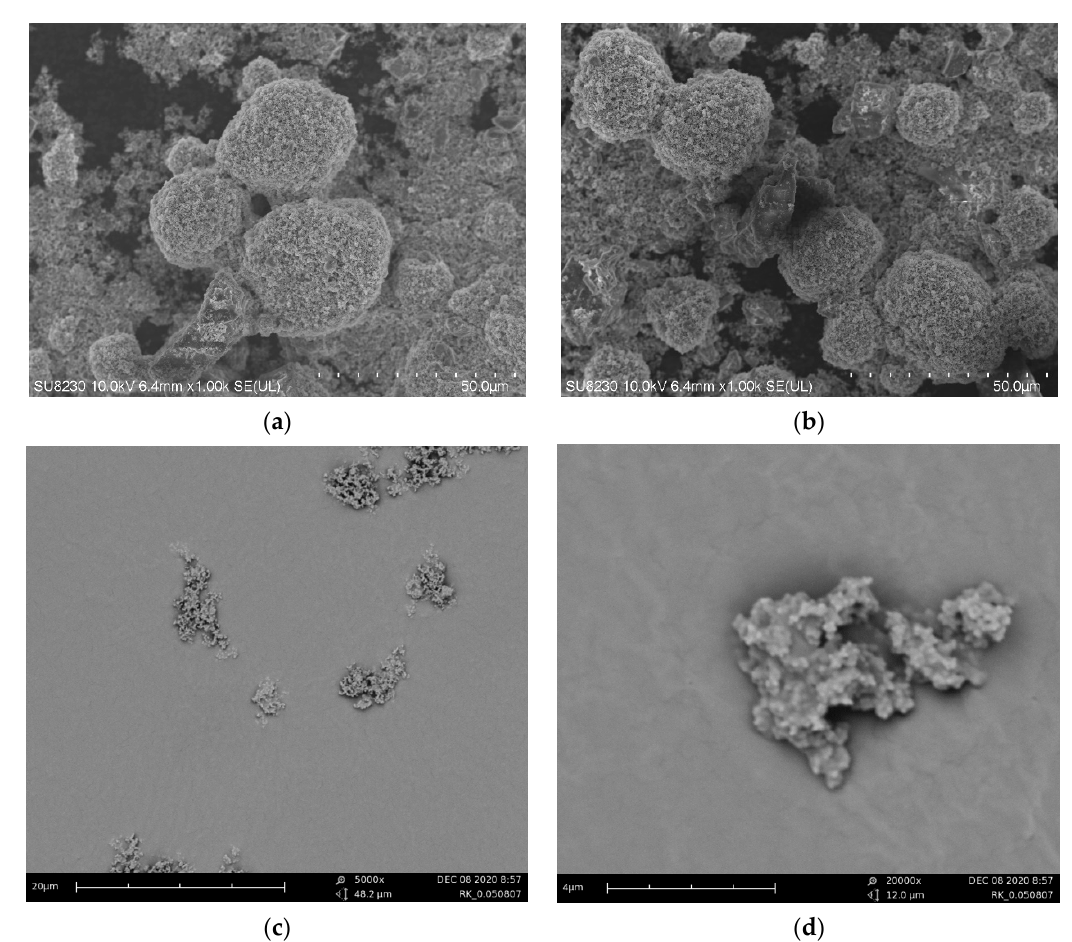
Figure 7. SEM images of TiO 2 agglomerates and aggregates structure. Images ( a , b ) present particles before deagglomeration. These images were obtained via Hitachi SUB8230. Images ( c , d ) present particles after deagglomeration. These images were obtained via PhoenomWorld Phoenom G1.